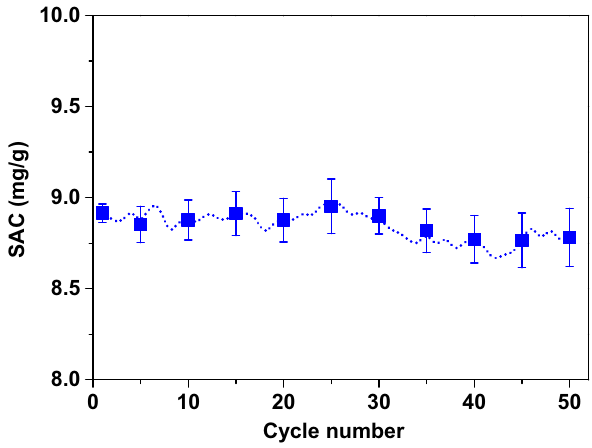
Figure 8: The variation of desalination capacity during 50 cycles for mAC/Gt/PVA - GA/Ti